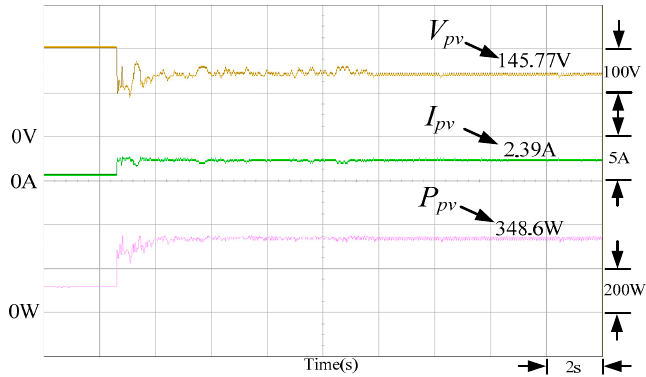
Figure 7. Output P–V curve of Case 1 photovoltaic module array.